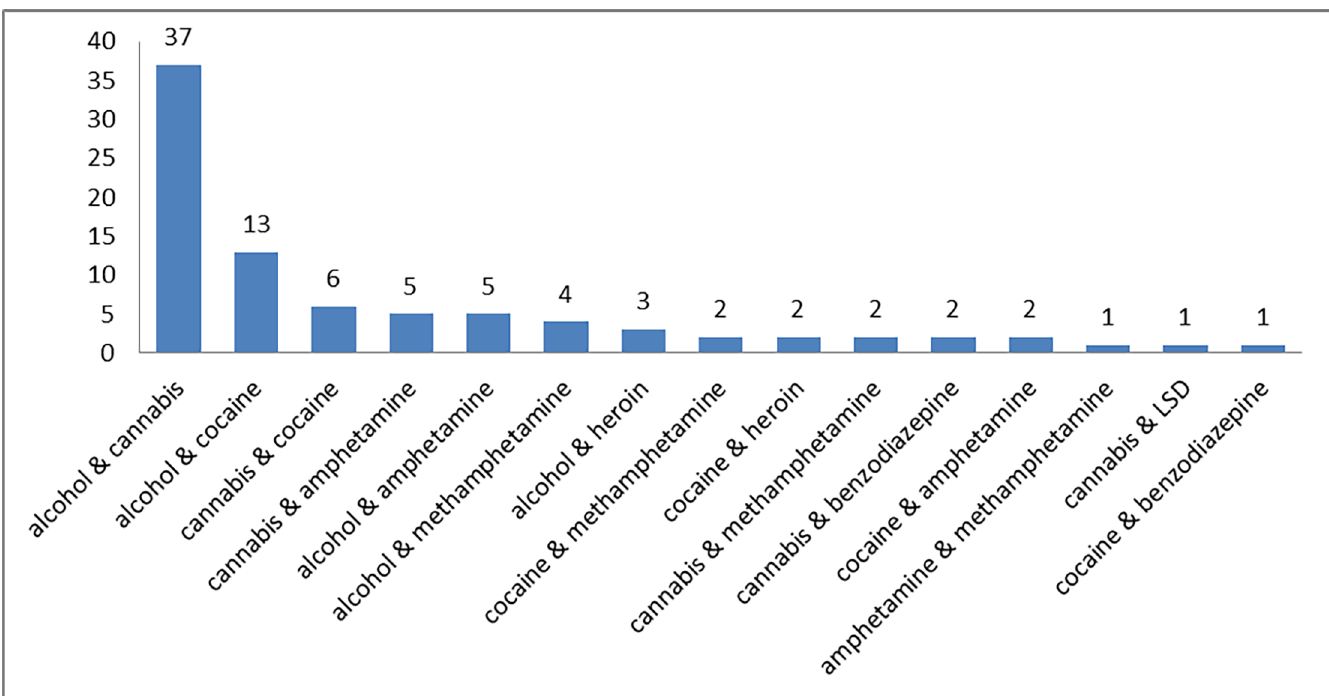
Fig 3. Frequency of reported substance combinations.